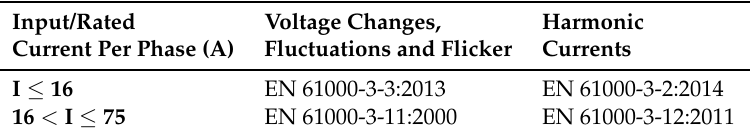
Table 5. Harmonized standards for disturbances in voltage and current.